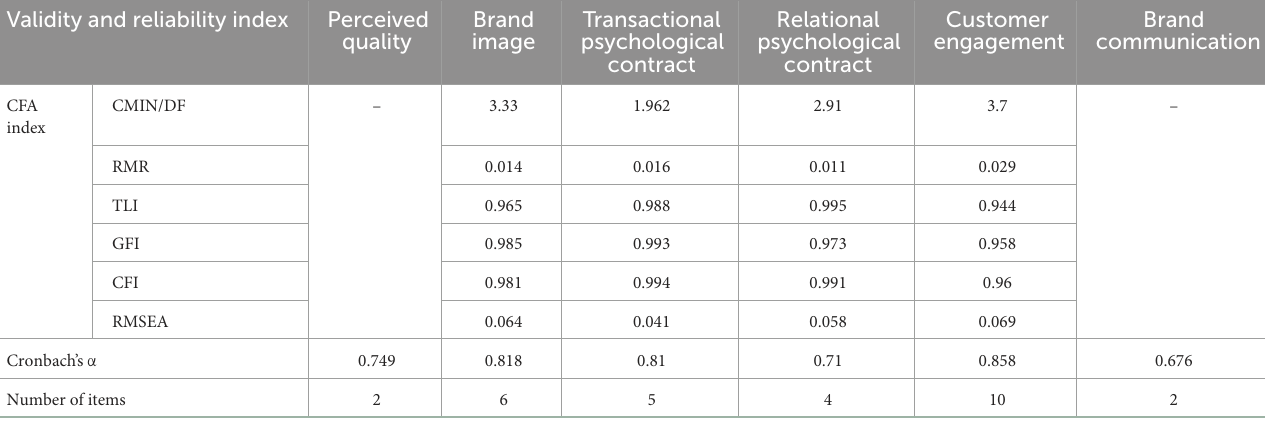
TABLE 2 Reliability and convergent validity result for measurements of